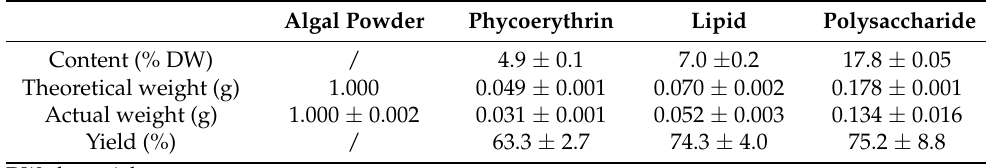
Table 1. The yield of phycoerythrin, lipid, and polysaccharide in the fractional extraction. Algal Powder Phycoerythrin